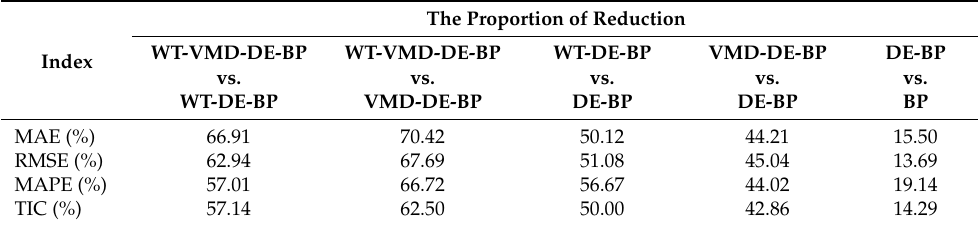
Figure 13. Error graphics of different models (Wuhan). Table 3. The comparison results of Comparisons I, II and III